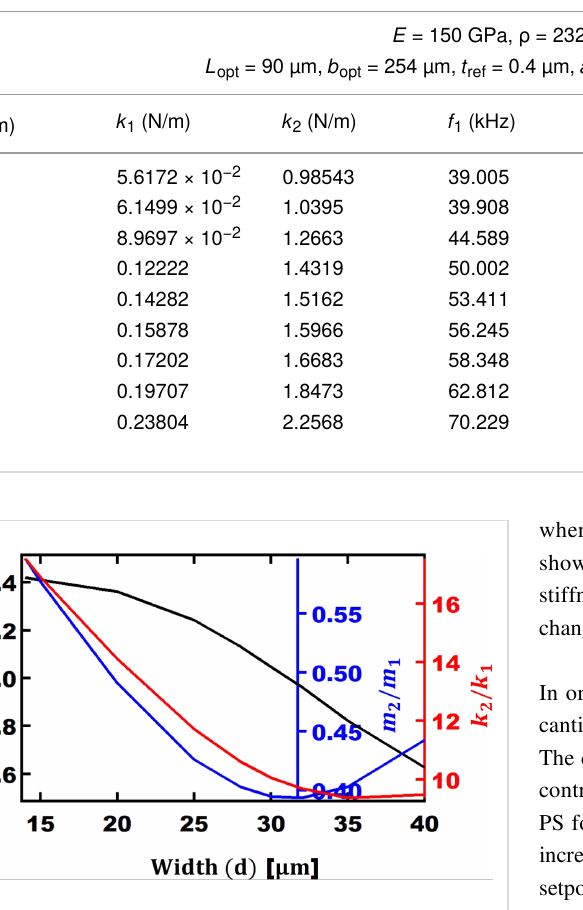
Table 4: Range of each leg’s widths ( ) for V-shaped cantilevers with calculated properties. Specifications of the V-shaped cantilever